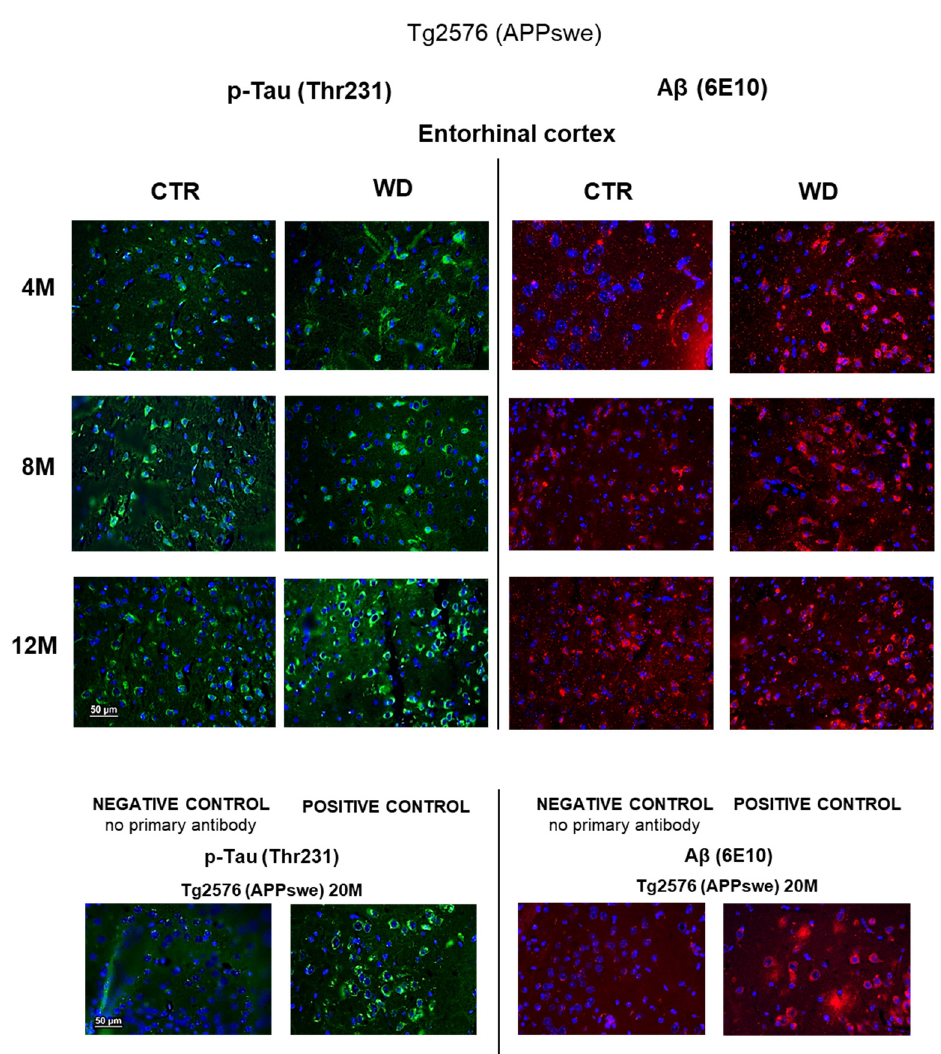
Figure 7. p-Tau(Thr231) and A β immunostaining in the entorhinal cortex of the transgenic mouse model of AD in three age groups—4M, 8M, and 12M. Negative and positive controls to staining specificity were performed in 20-month-old transgenic AD model mice—Tg2576 (APPswe). Magnification 400×.